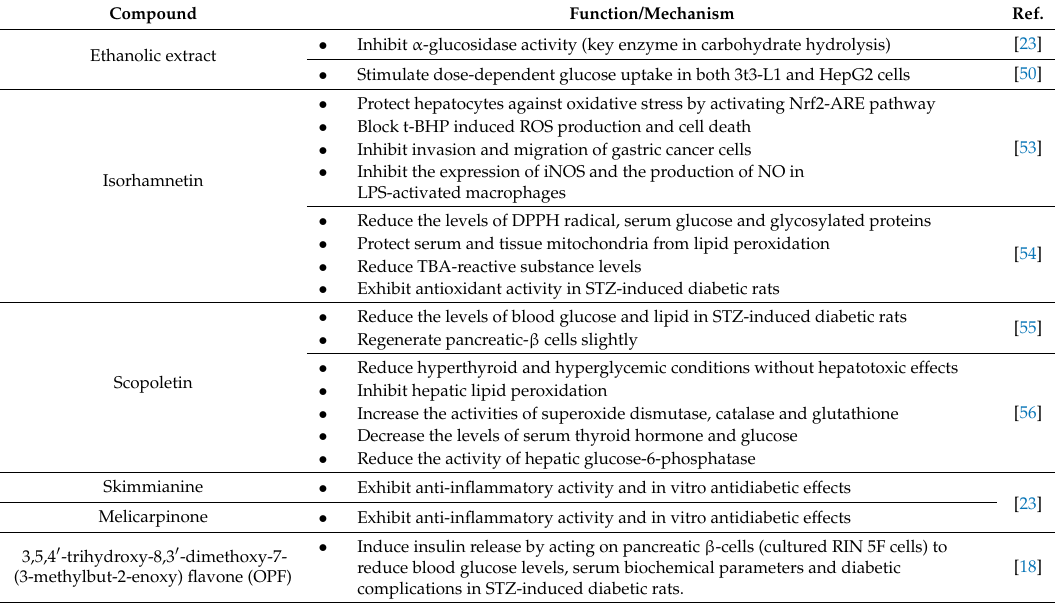
Table 5. Brief description of functions or mechanisms of compounds isolated from M. lunu-ankenda for antidiabetic activity. ARE: antioxidant response element; DPPH: 2,2-diphenyl-1-picrylhydrazyl;